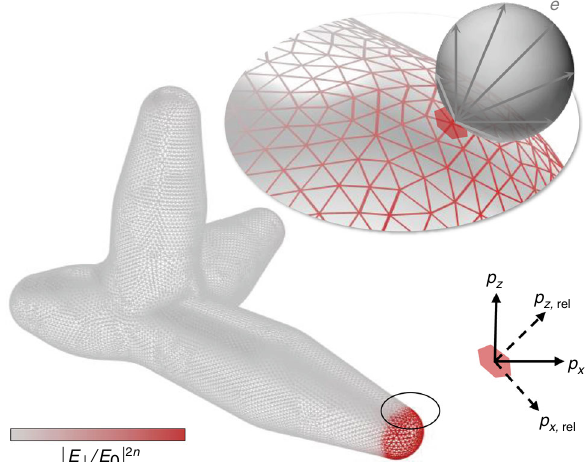
Fig. 6 Surface photoemission simulation geometry. Example nanostar surface mesh and nonlinear fi eld enhancement distribution utilized in theoretical 3D photoemission calculations. Multiphoton photoemission distributions are calculated with respect to the surface normal for each nanostar surface area element (e.g., shaded patch) corresponding to each triangular mesh vertex at which the surface fi eld enhancements are